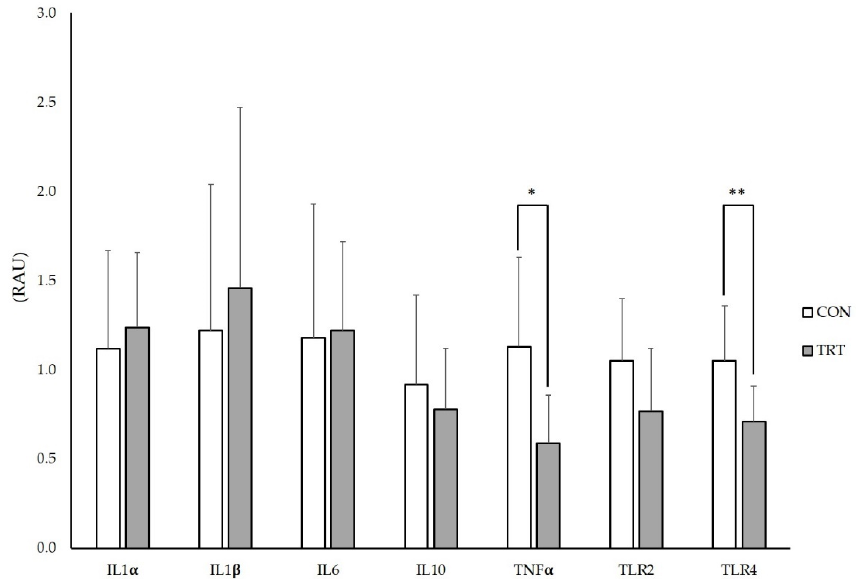
Figure 2. mRNA expression levels of genes encoding intestinal pro-inflammatory mediators in ileal Peyer’s patches of postweaning piglets supplemented with mannan oligosaccharides. Data shown as LSMeans ± SEM. Values are expressed as relative arbitrary unit (RAU). CON (n = 10): animals receiving the basal diet with no MOS supplementation; TRT (n = 10): animals receiving the basal diet with 0.2% MOS supplementation; PCR reactions were normalised to the Ct values of the reference genes β-actin and glyceraldehyde 3-phosphate dehydrogenase (GAPDH) of S. scrofa , and differential expressions were determined using the comparative Ct method; LSMeans: least-square means; SEM: standard error of the mean; * significant at p < 0.05; ** significant at p < 0.01.